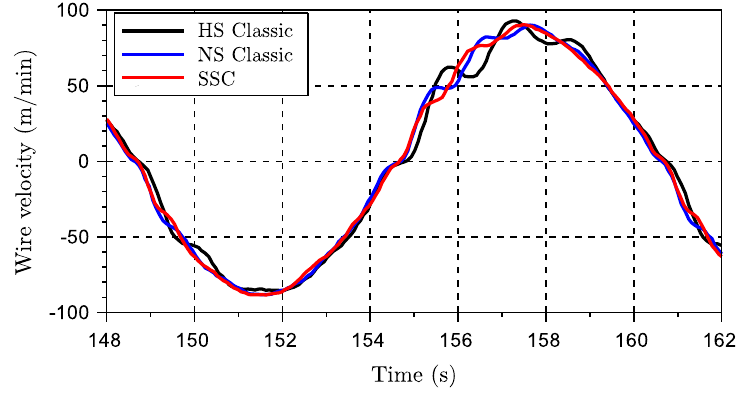
Figure 19. Wire velocities for scenario 2.